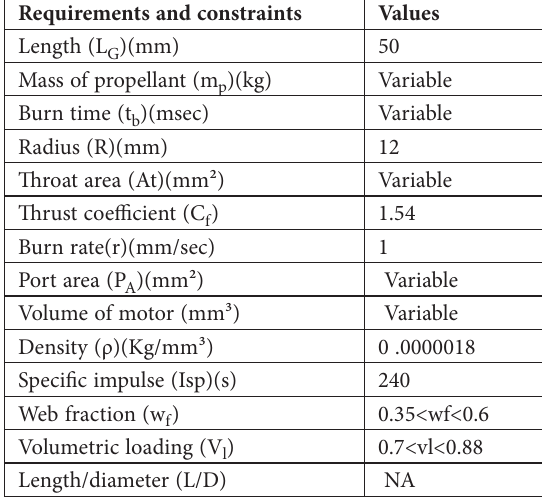
Table 1. Main system constraints for the current